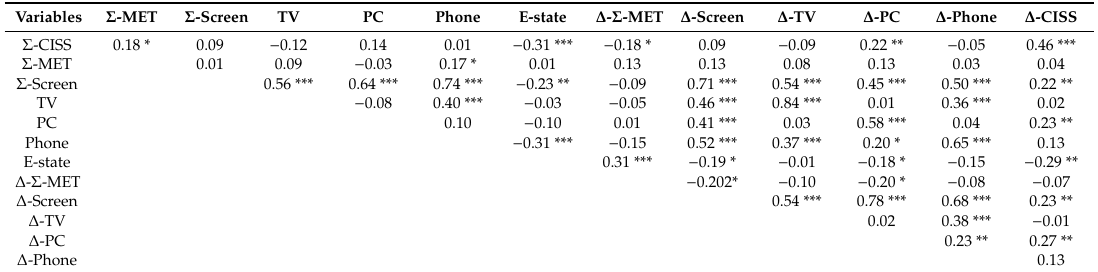
Table 3. Pearson’s correlations between variables during isolation